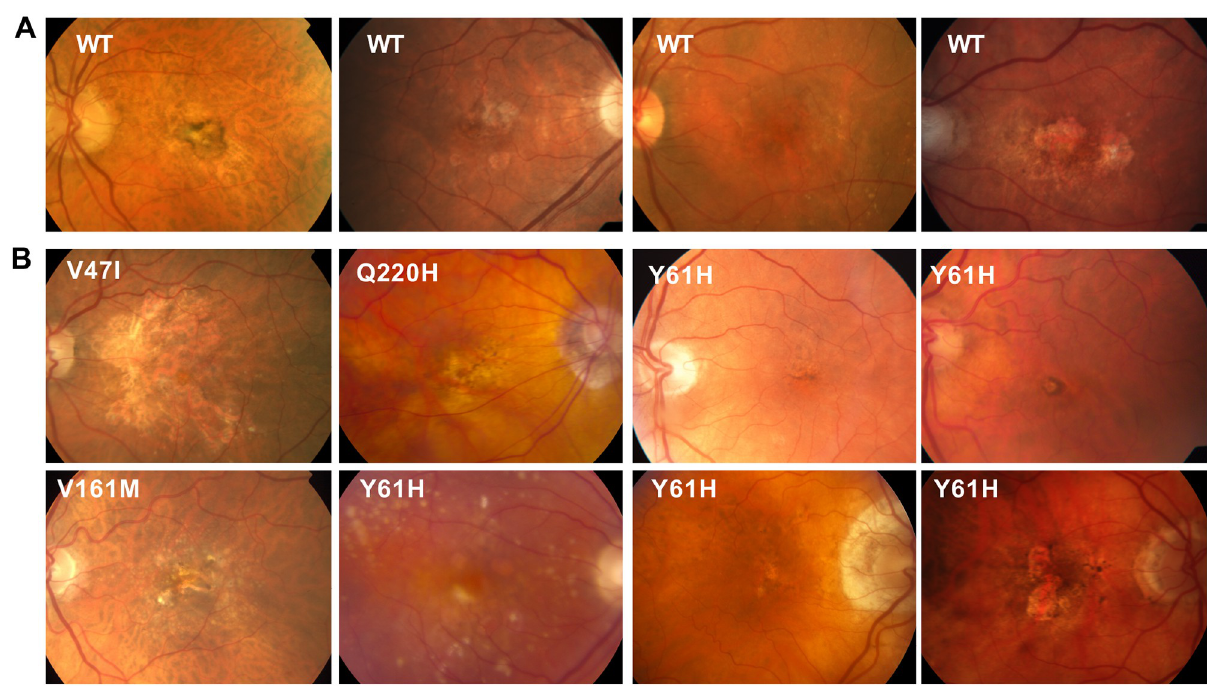
Fig 8. Clinical images of patients in the low-luminance deficit quartile Q1. Color fundus photos (CFP) from participants in the HARBOR trial (A) Q1 non-carriers for CIDEC rare variants (B) Q1 rare variant CIDEC carriers. CFP in both groups demonstrate typical clinical features of macular degeneration such as pigmentary changes, drusen, geographic atrophy and choroidal neovascular lesions. No obvious phenotypic differences are noted between the two groups.